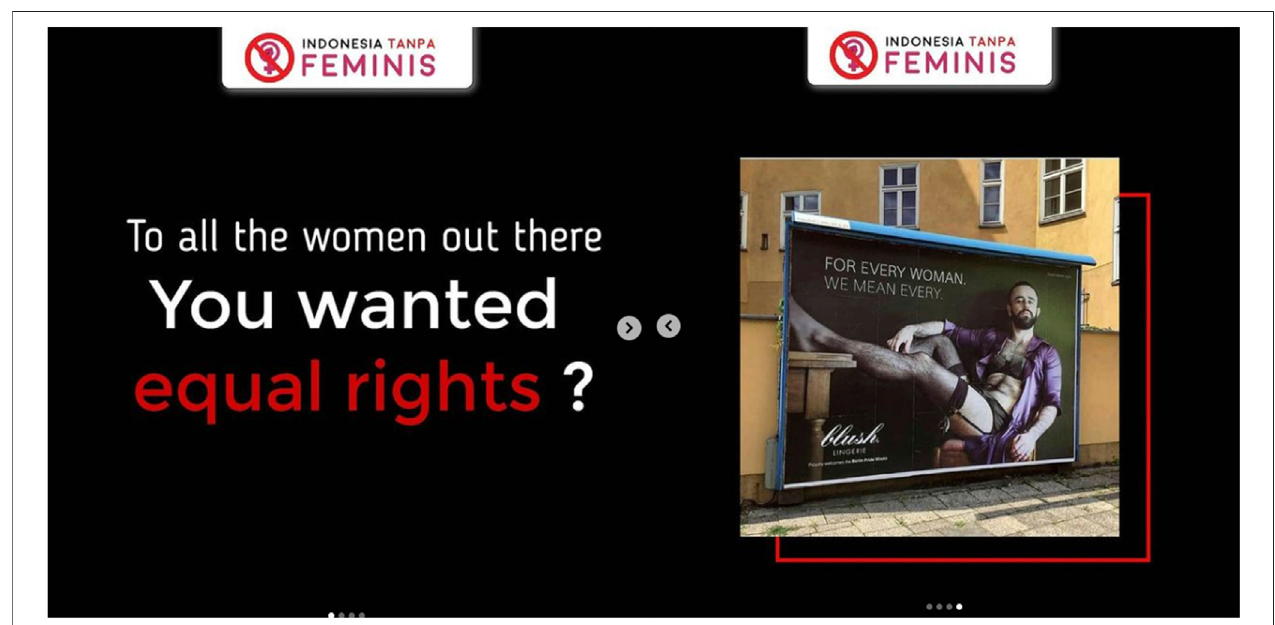
FIGURE 1 | The mockery toward the idea of equality (Posted by @indonesiatanpafeminis.id on July 06, 2020).